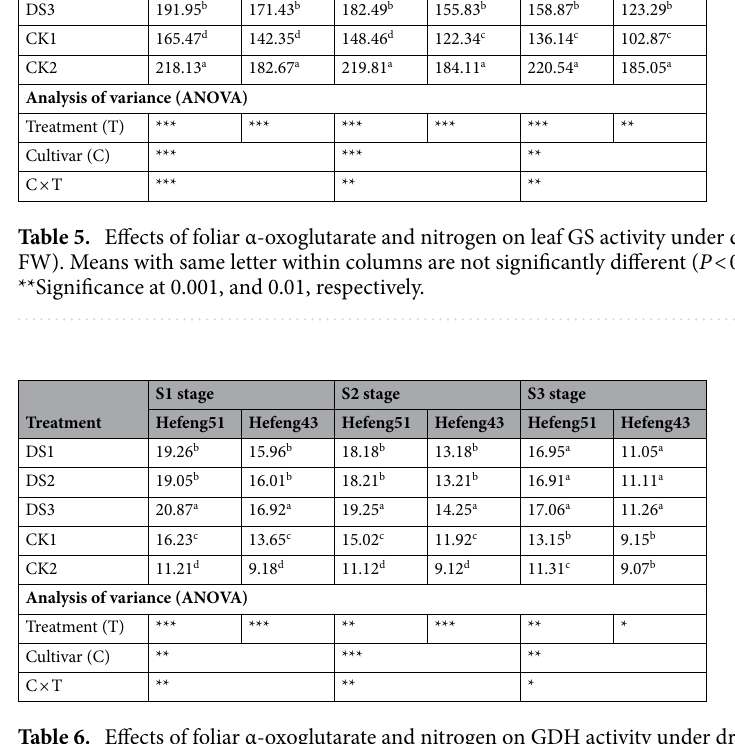
Table 6. Effects of foliar α-oxoglutarate and nitrogen on GDH activity under drought stress (µmol h −1 g −1 FW). Means with same letter within columns are not significantly different ( P < 0.05) using LSD test. ***, **, *Significance at 0.001, 0.01, and 0.05,